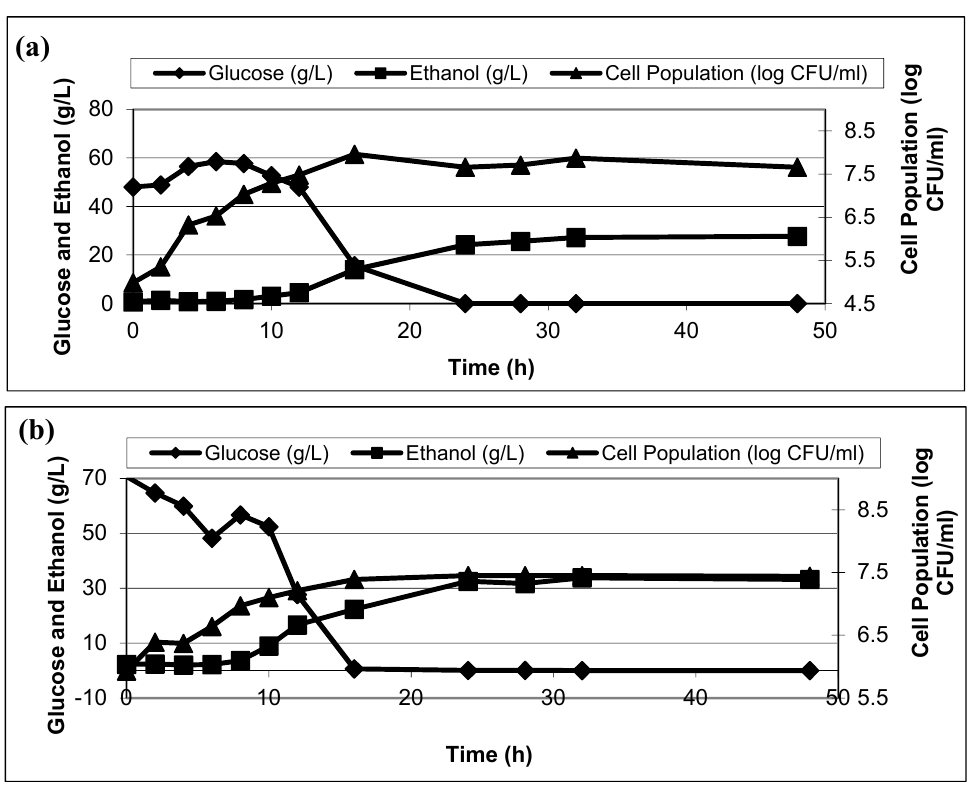
Figure 2. Ethanol, glucose, and cell population in the fermentation broth with different inoculum size; 1% ( a ), 3% ( b ), and 5% ( c